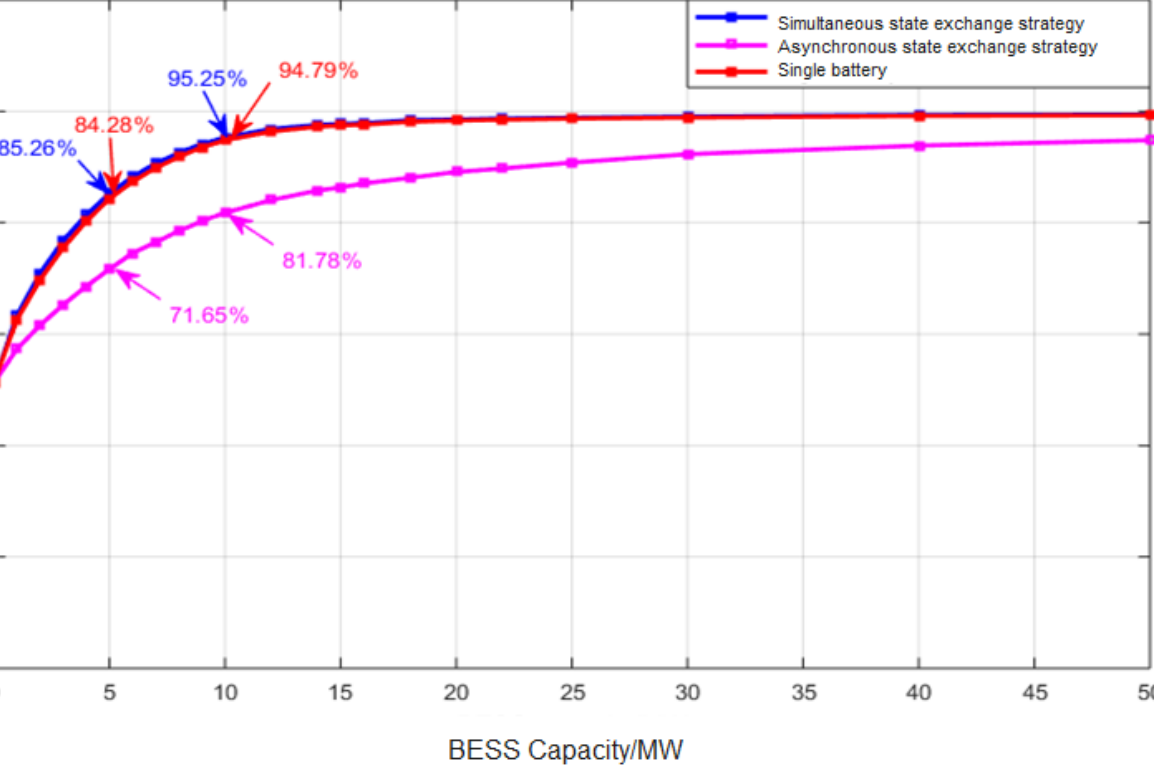
Figure 9. Expected injected energy deviation in various BESS capacities.